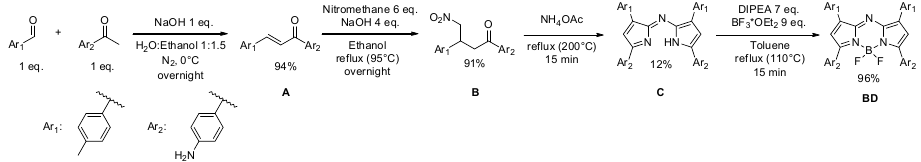
Scheme 1. Synthetic route to aminophenyl-substituted aza-BODIPY ( BD